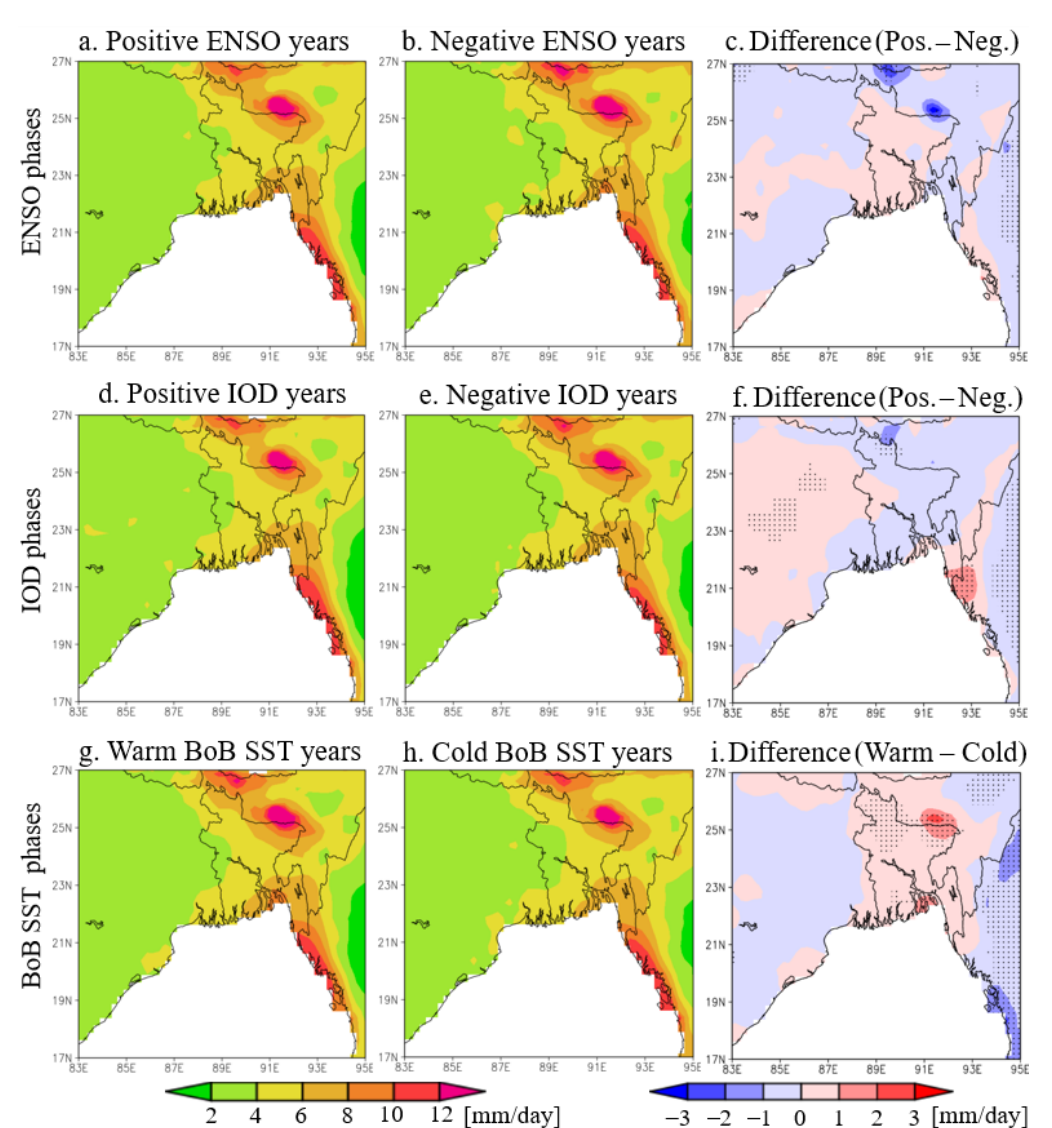
Figure 12. Mean precipitation (mm/day) during ( a ) positive and ( b ) negative ENSO years. ( c ) Difference in precipitation between positive and negative ENSO years. ( d , e ) Mean precipitation during positive IOD and negative IOD years and ( f ) their difference. ( g , h ) Mean precipitation during warm and cold BoB SST years and ( i ) their difference. The dots in ( c , f , i ) represent that the difference is statistically significant at the 95% confidence level.